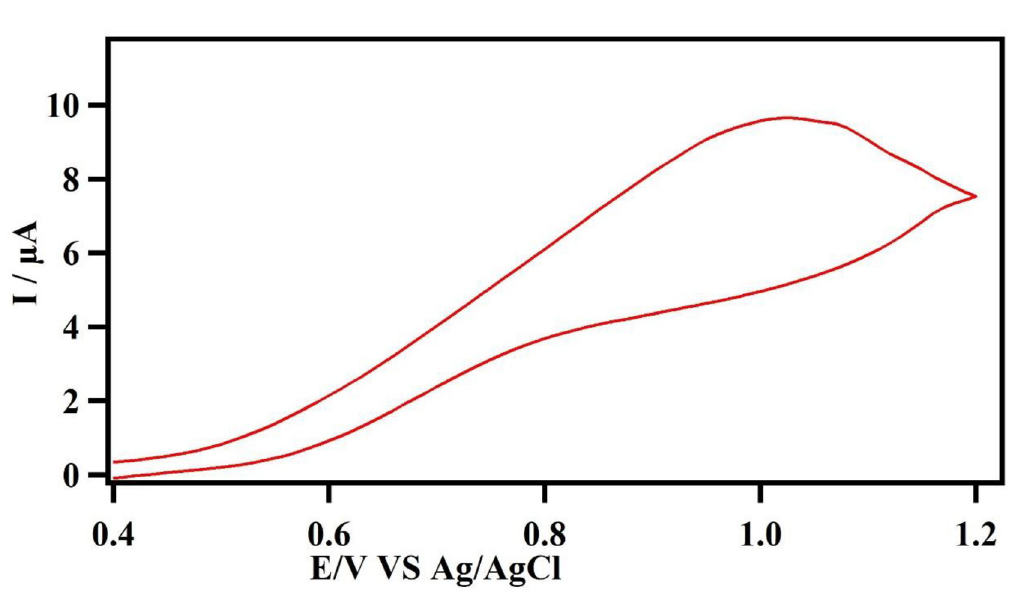
Fig 1. Cyclic voltammetry behavior of CBZ at the surface of bare carbon paste electrode in 0.1 mol L − 1 phosphate buffer electrolyte (scan rate: 100